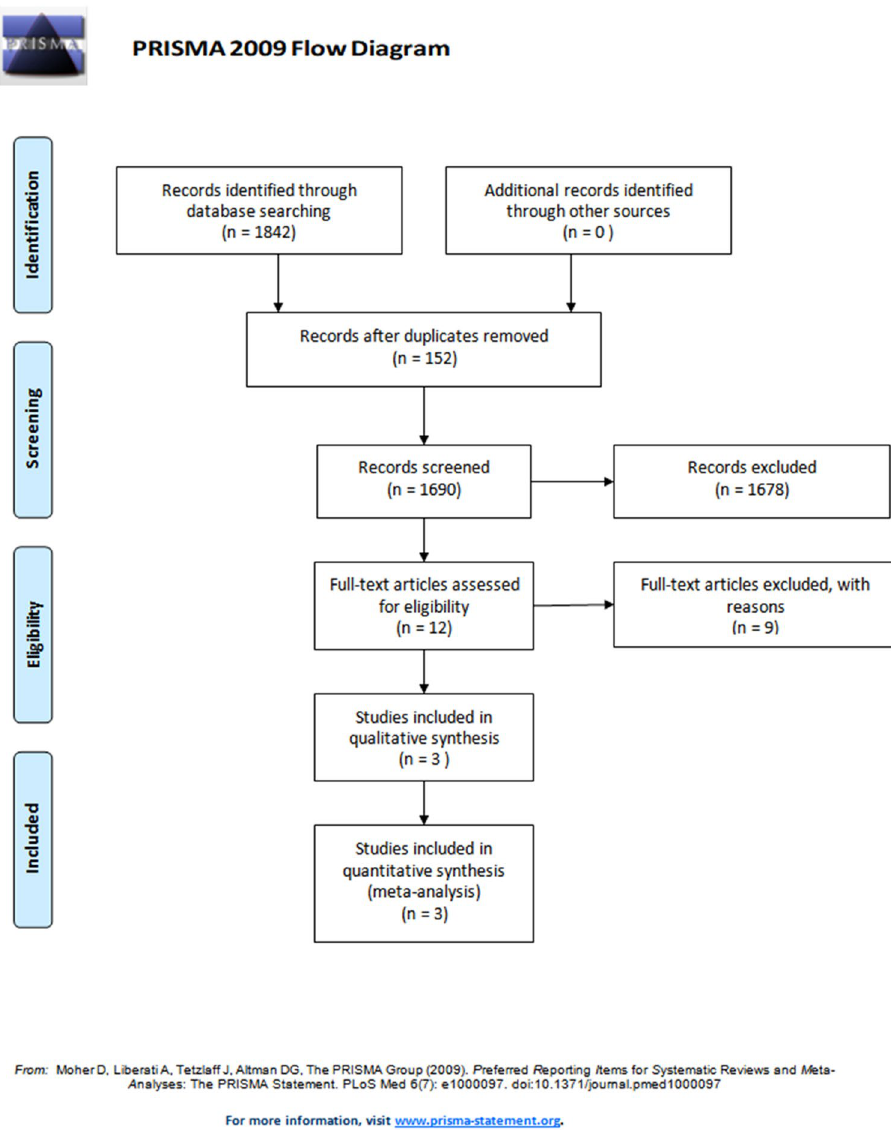
Figure 1. Flowchart showing the search results of the meta-analysis.